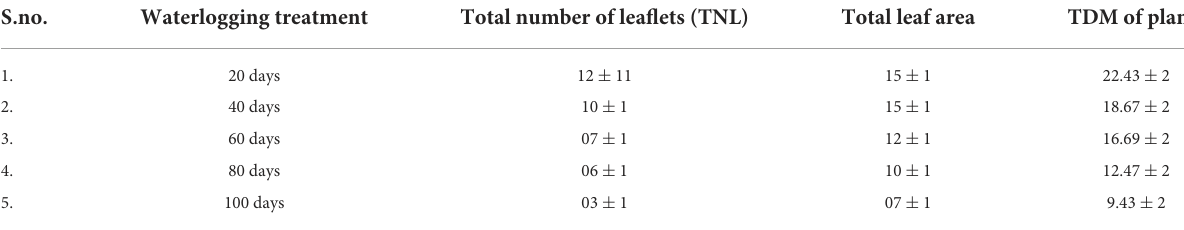
TABLE 2 The results of growth parameters under different waterlogging conditions. S.no.